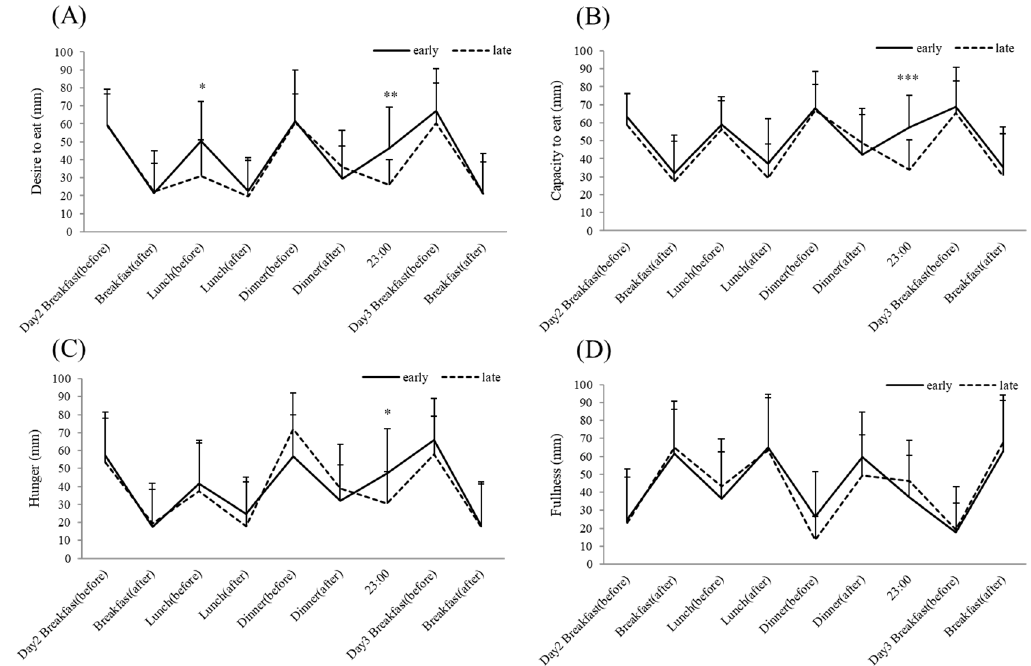
Figure 5. Eating dinner early modified temporal appetite patterns. ( A ) desire to eat, ( B ) capacity to eat, ( C ) hunger, ( D ) Fullness. * p < 0.05, ** p < 0.01, *** p < 0.001 (early dinner vs. late dinner), At timepoints without asterisks there was no significant difference between the two groups.